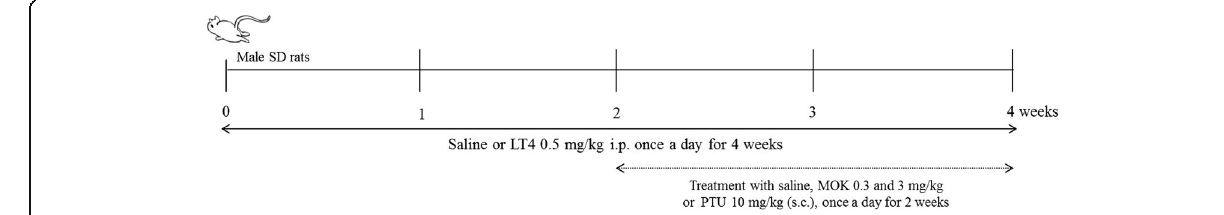
Fig. 1 Experimental design in rat model of